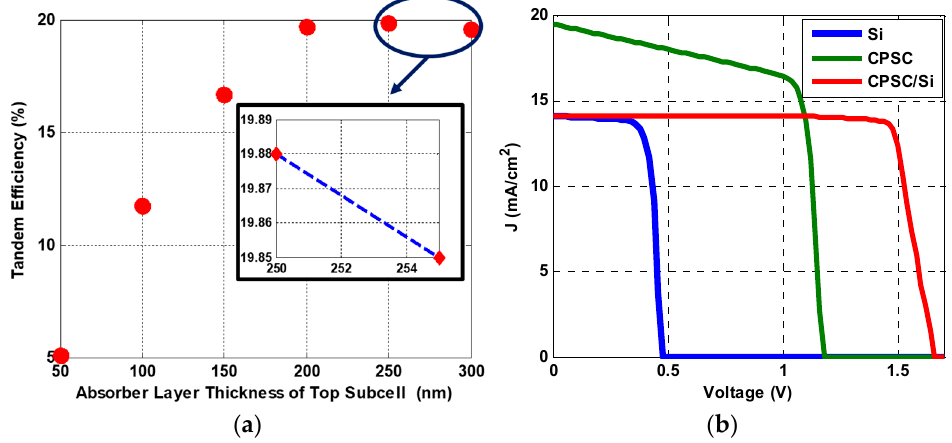
Figure 6. ( a ) PCE of CPSC/Si tandem solar cell with top cell absorber layer’s thickness, and ( b ) JV characteristics of CPSC/Si sub-cells along with the tandem solar cell.